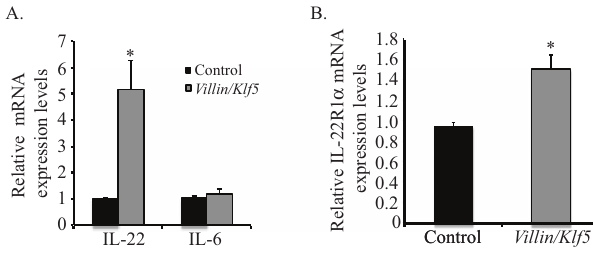
Figure 5. Klf5 overexpression increases IL-22 signaling in the colonic microenvironment following DSS treatment. ( A ) By quantitative real-time PCR, Villin-Klf5 mice had increased IL-22 mRNA expression in the colonic stromal compartment after 7 days of DSS treatment, compared to controls, while IL-6 mRNA expression was unchanged. ( B ) Quantitative real-time PCR of epithelial scrapings from control and Villin-Klf5 mice treated for 7 days with DSS showed increased IL-22R1 a expression in the epithelia of Villin-Klf5 mice.